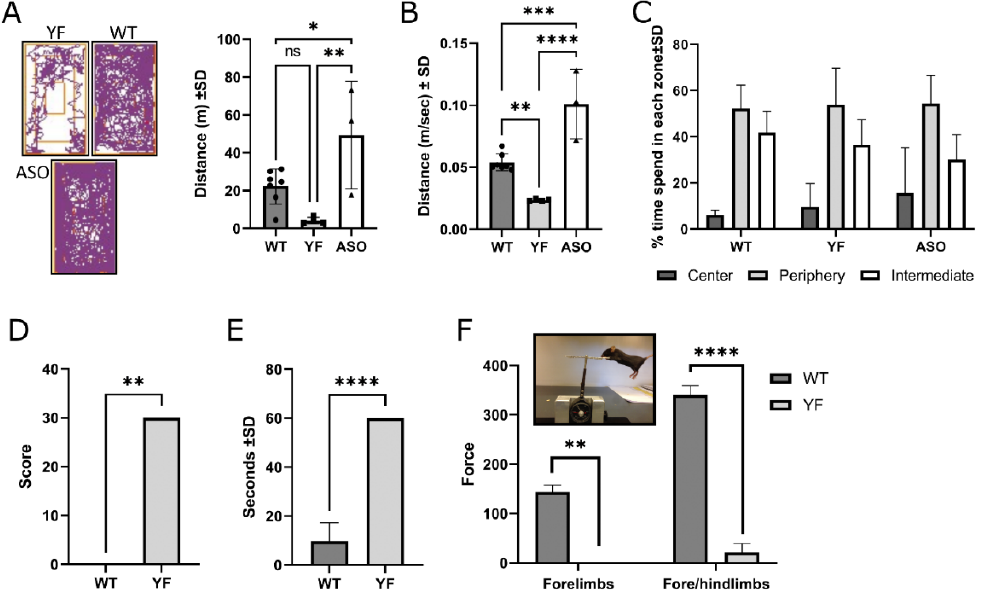
Figure 2. Behavioral compromises in YF mice. ( A ). Open-field analysis shows reduced walking distance by YF mice (7.5 months; n = 4) compared to wildtype (WT; n = 7) and ASO mice ( n = 3). ( B ). In the open-field test, YF mice also exhibit reduced walking compared to WT and ASO mice (speed measured in the mobile time (m/s)). ( C ). YF mice spend similar amounts of time in center, periphery, and intermediate zones compared to WT and ASO. ( D ). Clasping measured in YF and WT mice. Full clasping with both hind legs gives a score of 3. All YF mice ( n = 4, 7.5 months) received a full score of 3 in 10 tests (30 in total). WT mice ( n = 7) do not clasp at all resulting in a final clasping score of 0. ( E ). In the adhesive removal test, YF mice (7.5 months; n = 4,) are not able to remove the sticker placed on their noses during the experimental time of one minute. Each YF mouse is allowed to attempt to remove the sticker 3 times for 1 min each time. WT mice ( n = 6) are all able to remove the sticker when tested 1 or 2 times. ( F ). Force measured by a small apparatus (insert) measuring the mouse’s ability to hold on to a grid. WT mice ( n = 8) pull with a strength of 144 with their forelimbs, whereas YF mice ( n = 4) are unable to pull the grid. With all four legs, the WT mice pull with a strength of 340 (close to maximum limit of apparatus), whereas YF mice pull with a force of only 21. Data are depicted as mean ± standard deviation (SD); depending on the variance of the data and the number of experimental groups, the data was analyzed by one-way ANOVA with multiple comparisons, Mann–Whitney test or unpaired t -test. * p < 0.05, ** p < 0.01, *** p < 0.001, **** p <